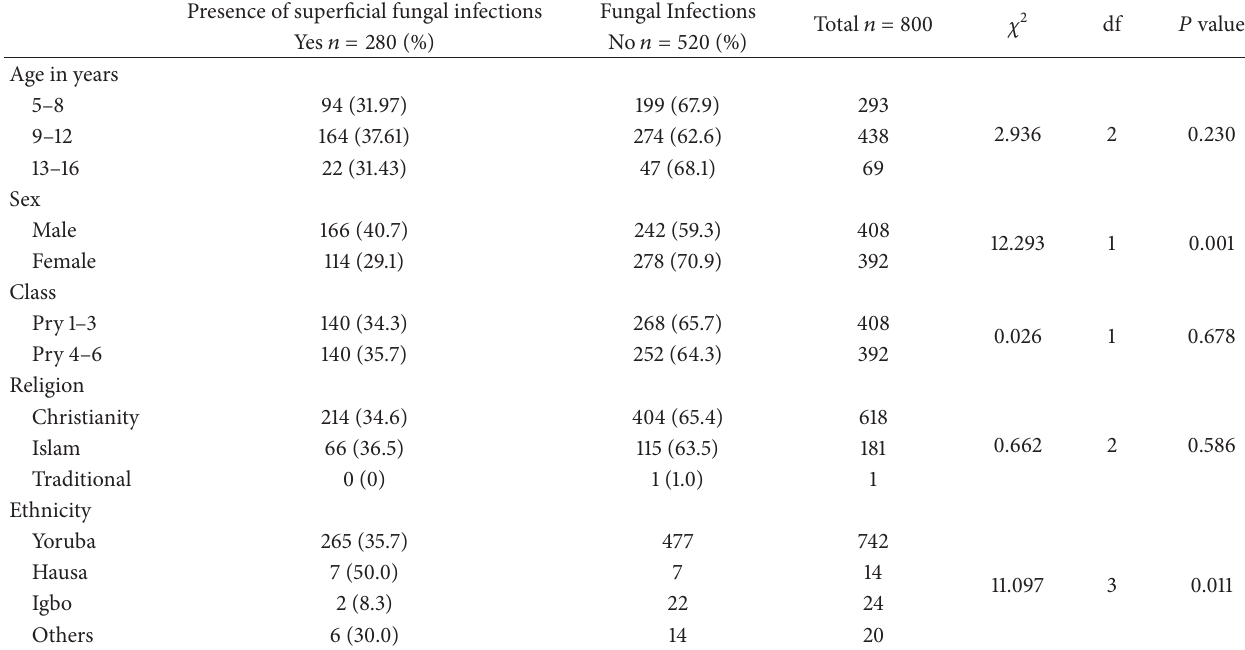
Table 1: Relationship between the sociodemographic characteristics and the presence of superficial fungal infections.